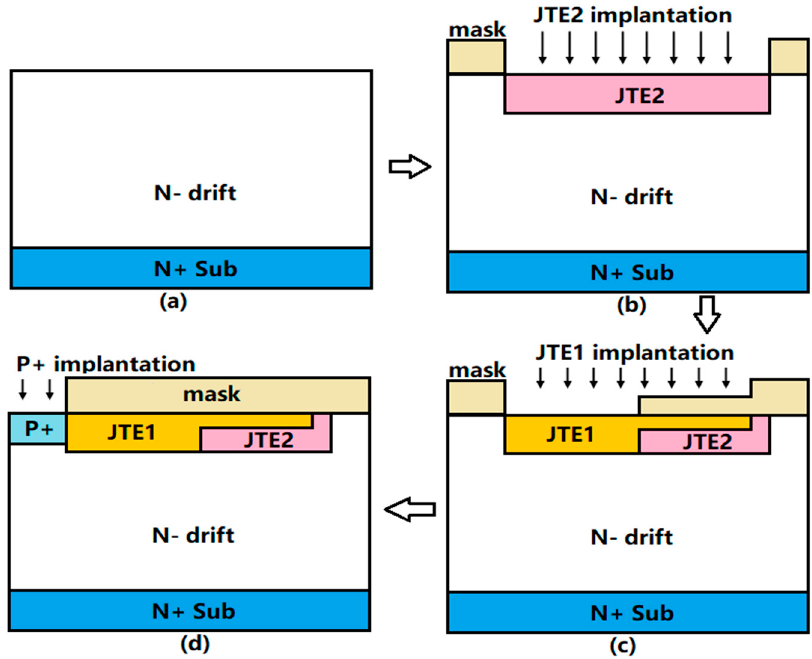
Figure 2. Fabrication procedure of making step JTE in the Step-DZ-JTE. ( a ) Base layers. ( b ) JTE2 region formed by ion implantation. ( c ) JTE1 region fromed by ion implantation with the specific mask. ( d ) Main junction P+ formation.